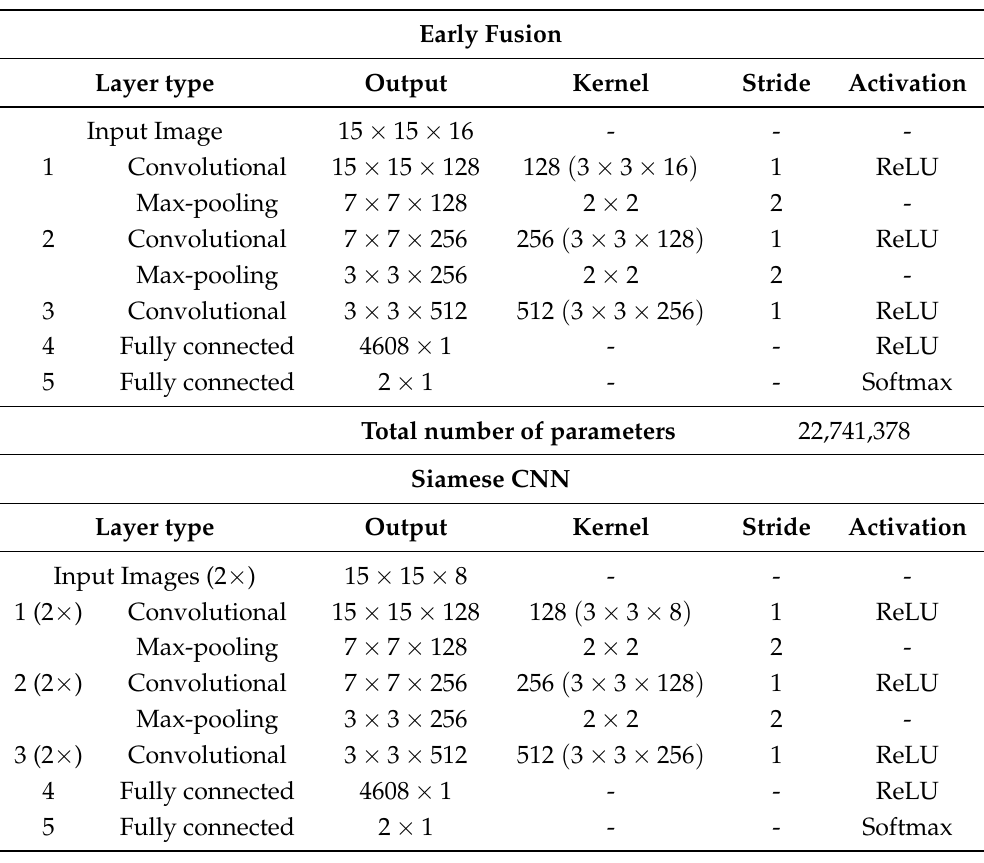
Table 3. Detailed description of EF and S-CNN